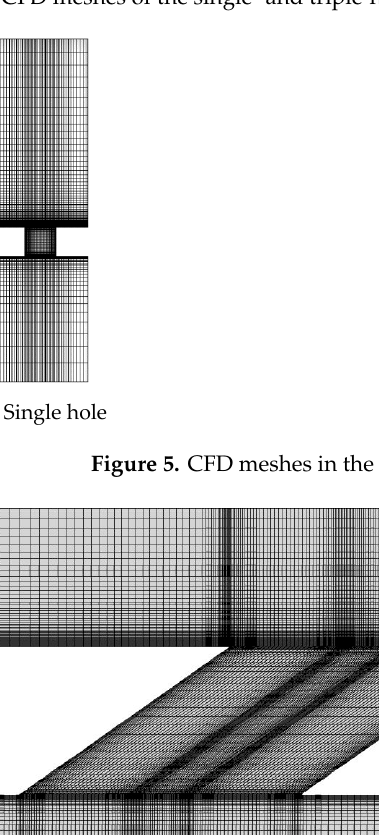
Figure 4. CFD meshes of the single- and triple-hole systems in the xy plane.